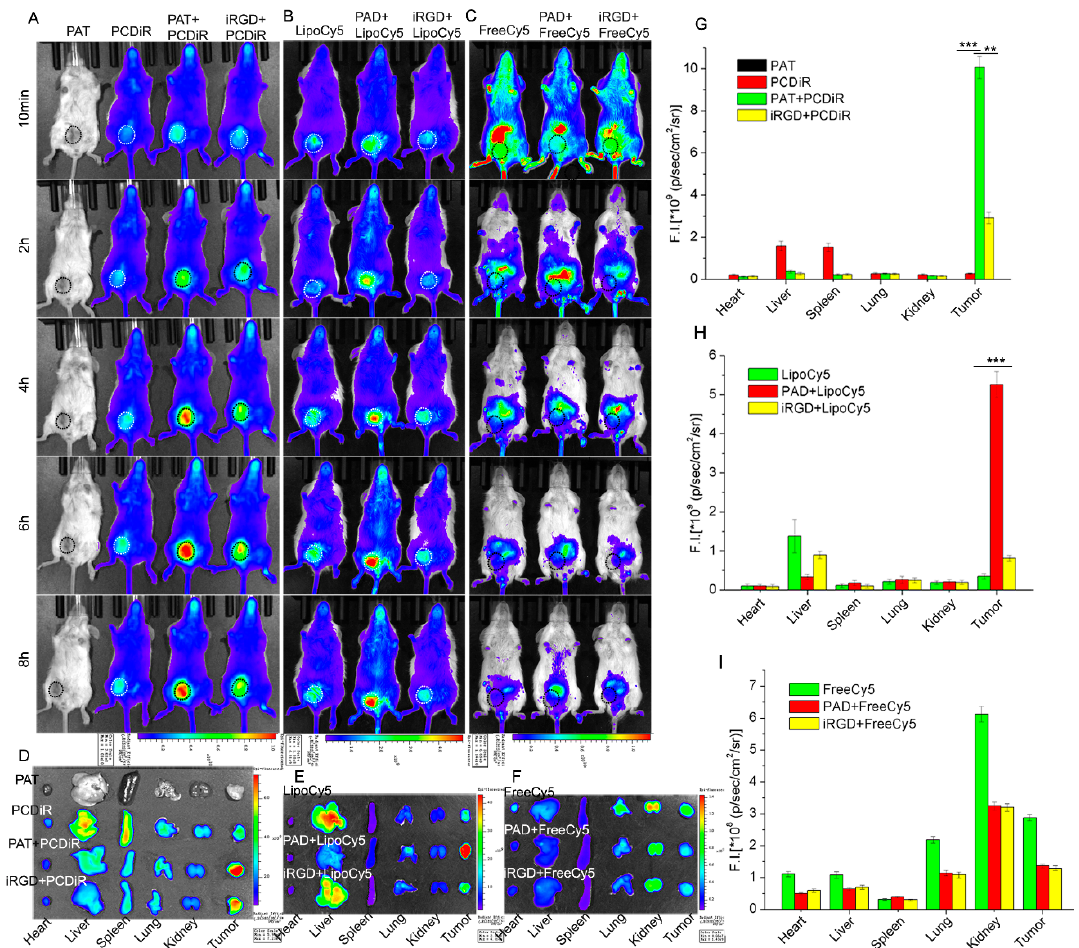
Figure 1. Enhanced tumor enrichment of nanoparticles coadministered with APPA self-assembled peptosomes. In vivo fluorescence imaging of mice to compare tumor delivery e ffi ciency of APPC self-assembled nanoprobes coadministered with PAT ( A ), Cy5-containing liposomes coadministered with PAD ( B ), and free Cy5 fluorescent probes coadministered with PAD ( C ). Tumors in (A), (B) and (C) panels are highlighted with circles. Ex vivo fluorescence imaging of tumors and main organs harvested ( D ), ( E ) and ( F ) and their quantified intensities ( G ), ( H ) and ( I ) from the mice shown in (A), (B) and (C), respectively. Results are shown as mean fluorescence intensity ± SD ( n = 3), ** p < 0.01, *** p < 0.001.